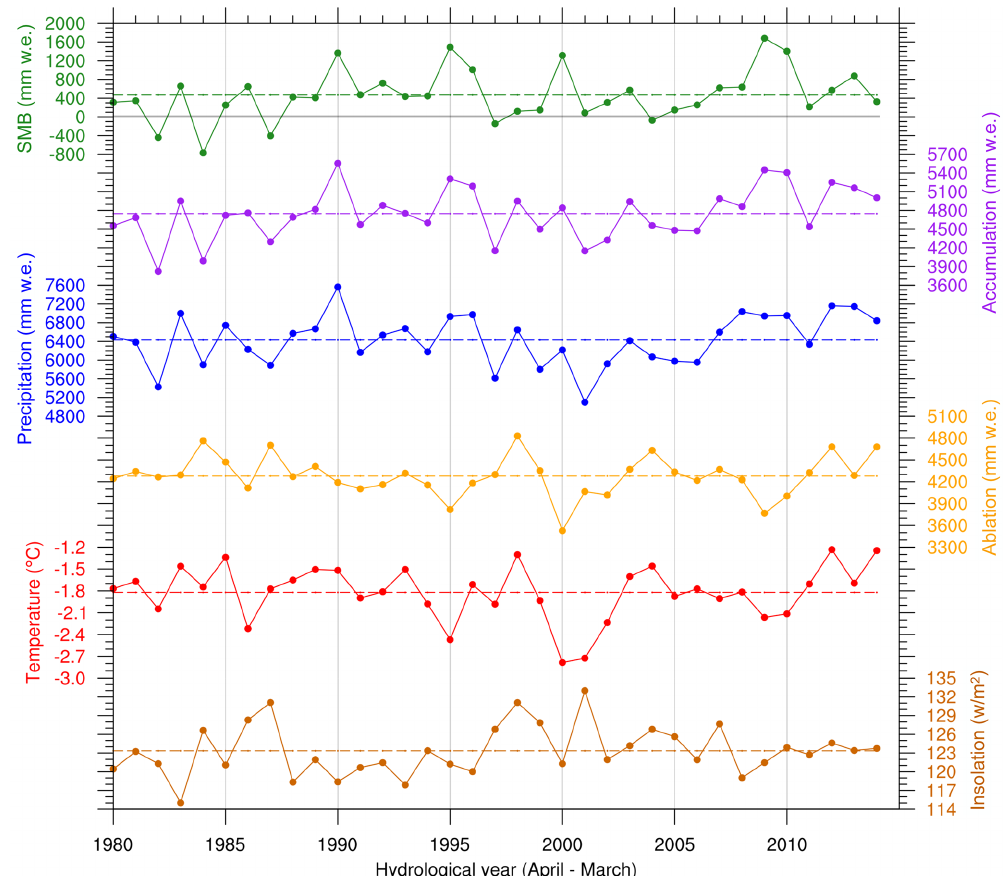
Figure 4. Annual (April to March) time series of spatially averaged (over the area of the Patagonian Icefields) fields of (from top to bottom) SMB, accumulation, accumulated precipitation, ablation, mean near-surface temperature, and mean insolation. Each segmented line indicates the mean value of the series. The grey horizontal line corresponds to the SMB zero